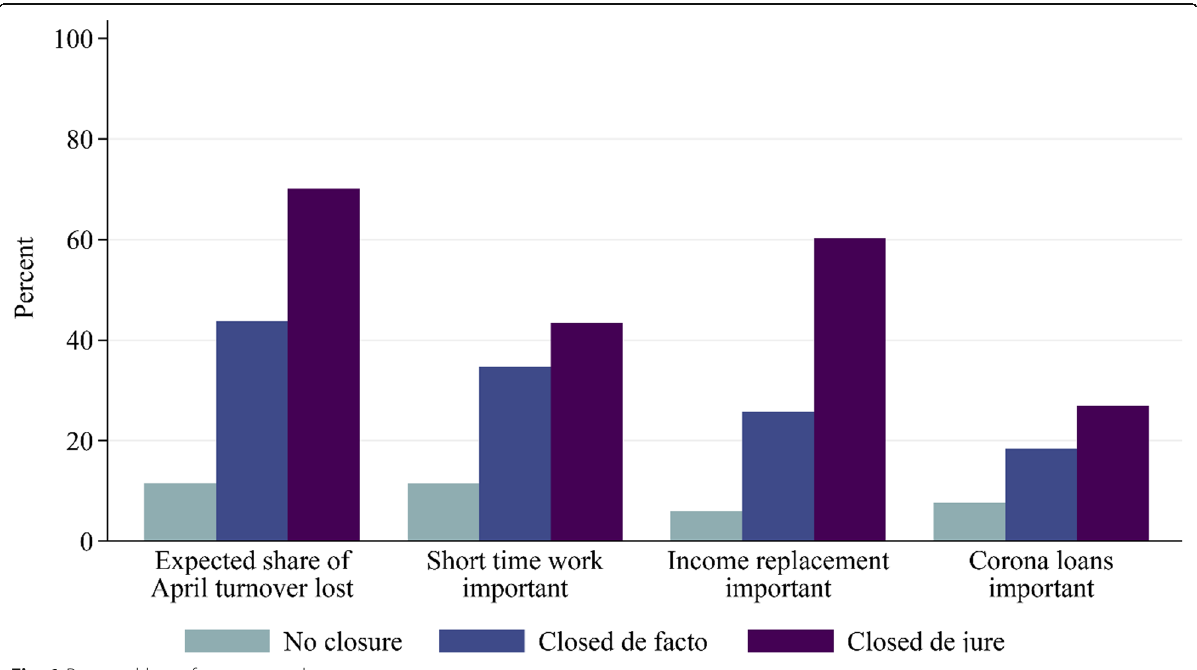
Fig. 1 Reported loss of turnover and recourse to support